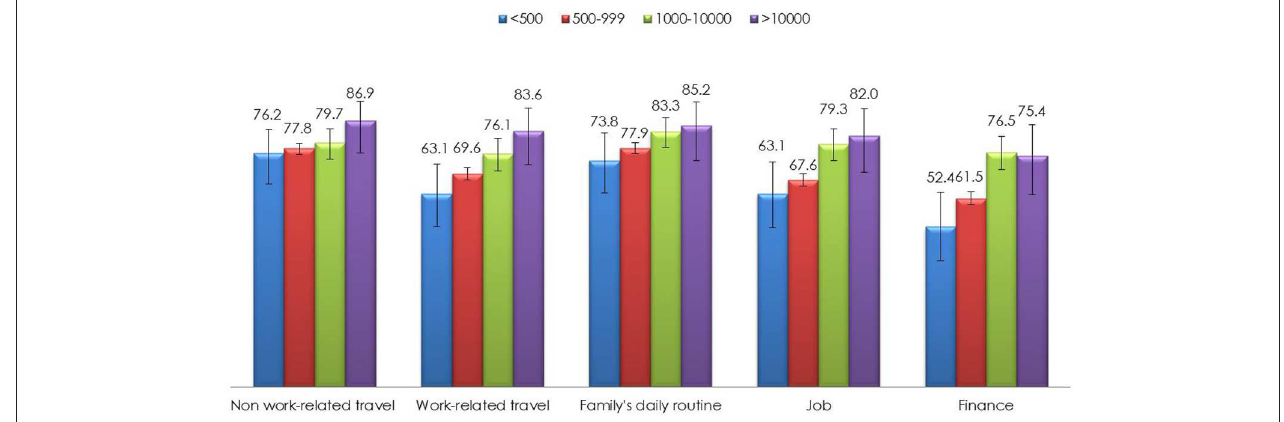
FIGURE 2 | Proportion of “A great extent/somewhat” responses for impact of COVID-19 items by provinces with cumulative confirmed cases ( N =